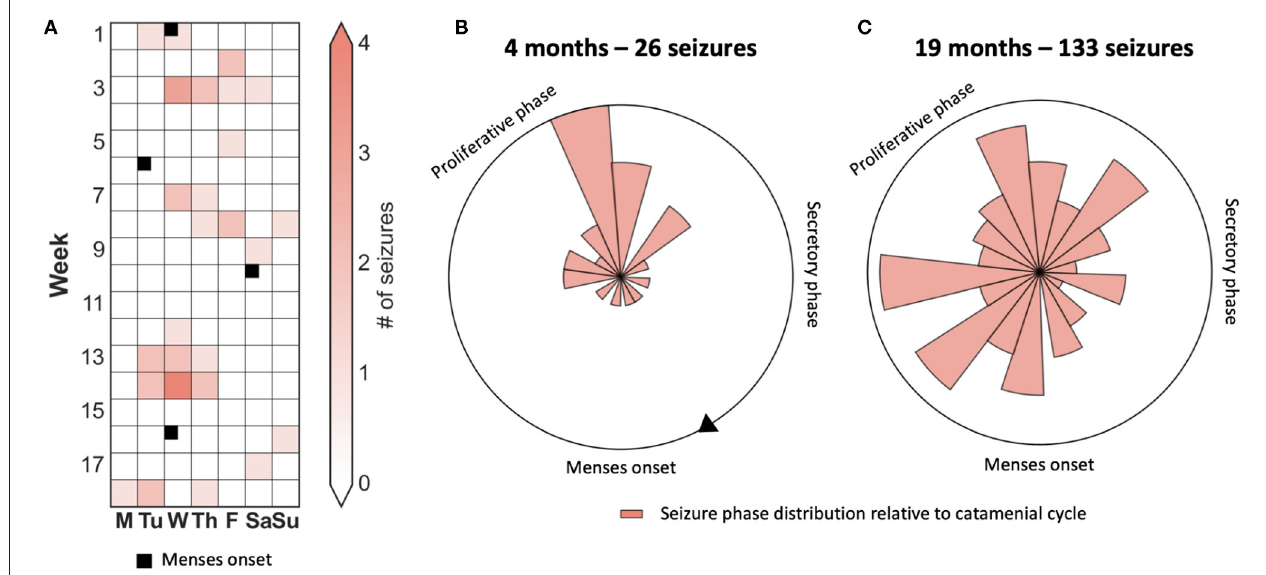
FIGURE 3 | Case study of a catamenial seizure cycle showing that seizures are only transiently aligned to the menstrual phase. (A) 4-month seizure diary showing days that seizures occurred, and times of menstruation, suggesting a catamenial seizure cycle. (B,C) Polar plots demonstrating the location of seizures with respect to the menstrual cycle after four months and 26 seizures (B) and after 19 months and 133 seizures (C)